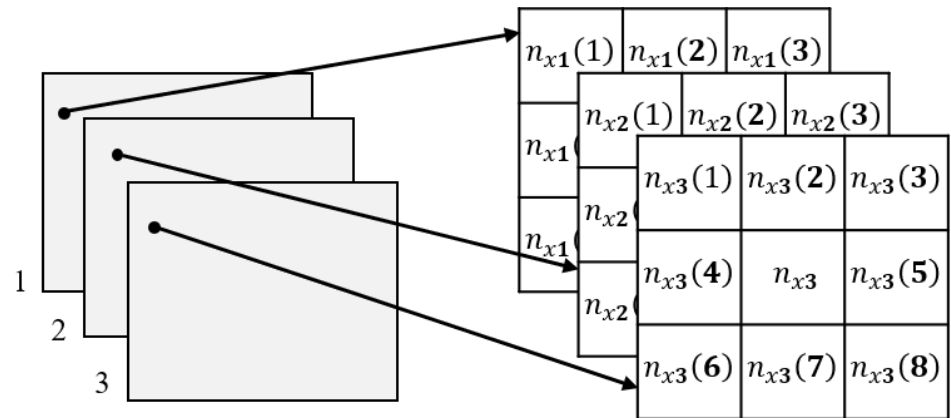
Figure 9. Improved background-model building